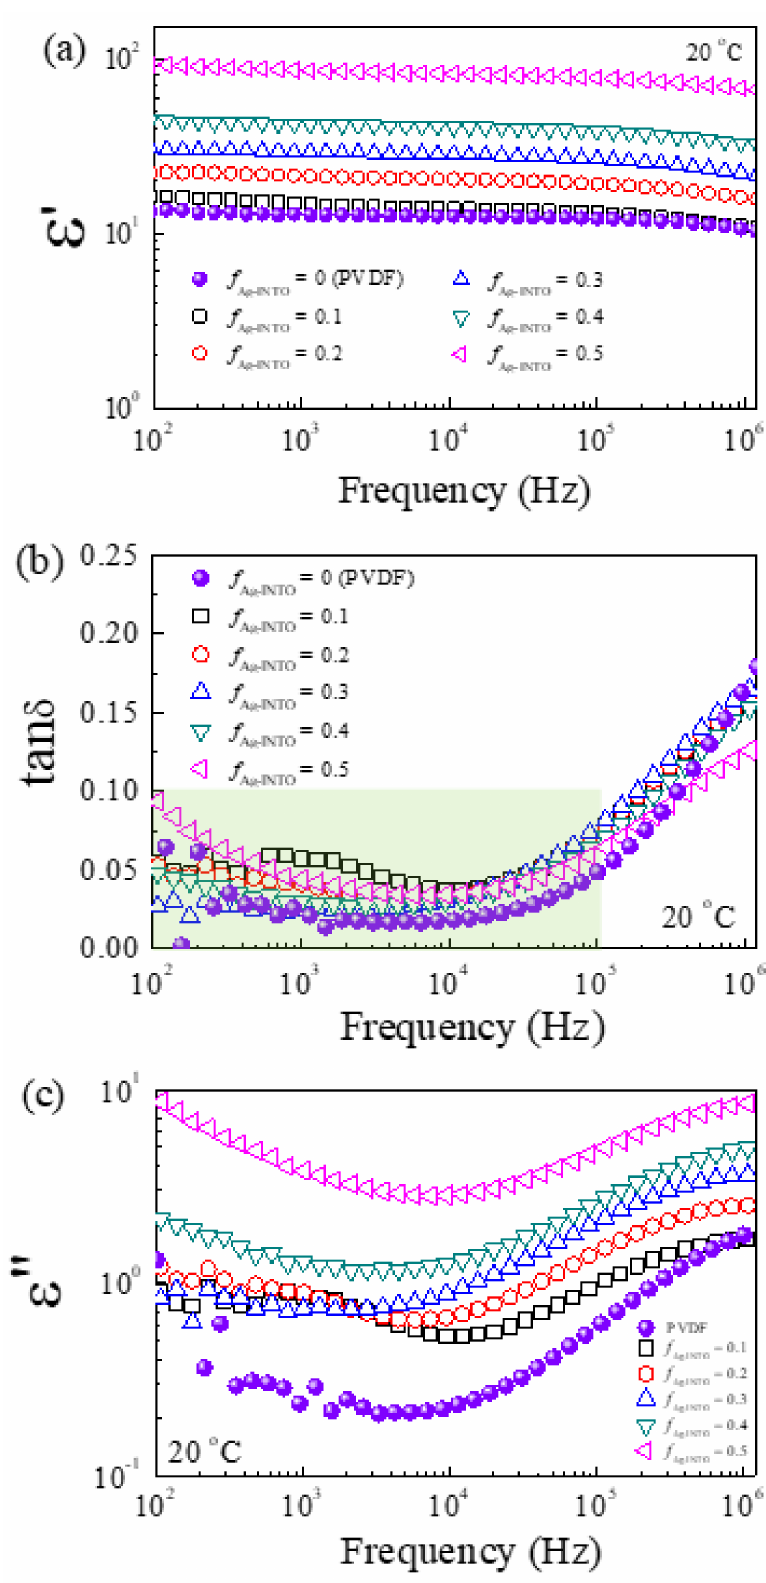
Figure 4. Frequency dependence of ( a ) ε (cid:48) , ( b ) tan δ , and ( c ) ε ” at 20 ◦ C for PVDF polymer and Ag − INTO/PVDF composites with different f Ag − INTO